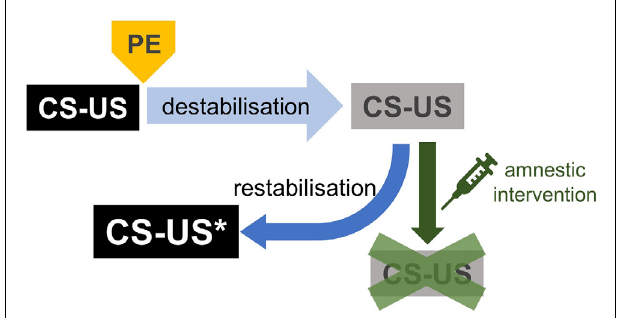
FIGURE 3 | CS-US memory processing after a brief retrieval. In the presence of prediction error (PE), brief retrieval induces CS-US memory destabilisation. Destabilised or labile CS-US memories are again susceptible to amnestic interventions, as they were during the consolidation phase. Labile CS-US memories are restabilised by a neural process dependent on de novo gene expression and protein synthesis. Restabilised CS-US memories return to a stable state, impervious to amnestic agents. Notably, reconsolidated CS-US memories become more precise and longer-lasting (CS-US*, see